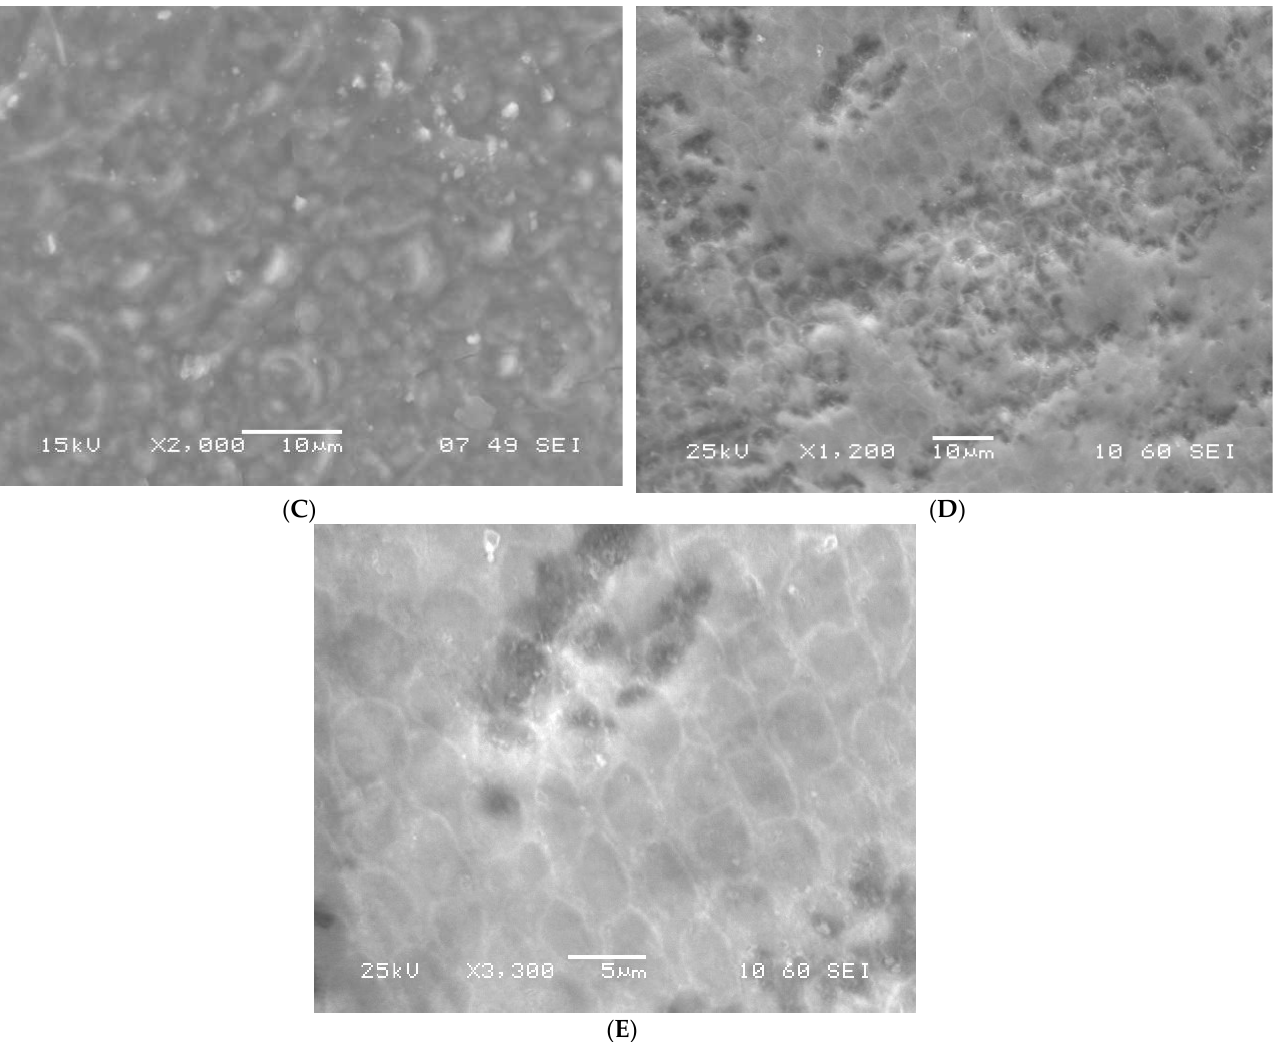
Figure 1. ( A ) SEM image of the labial surface of primary tooth showing irregular enamel in a diabetic patient; ( B ) SEM image of the labial surface of primary tooth showing enamel surface with normal ultrastructure in a healthy child; ( C ) SEM image of the labial surface of primary tooth showing aprismatic enamel in a diabetic patient; ( D ) SEM image of the labial surface of primary tooth showing enamel surface with a normal aprismatic layer in a healthy child; ( E ) SEM image of the labial surface of primary tooth showing enamel surface with a normal rod and inter-rod structure visible beneath the aprismatic layer in a healthy child.